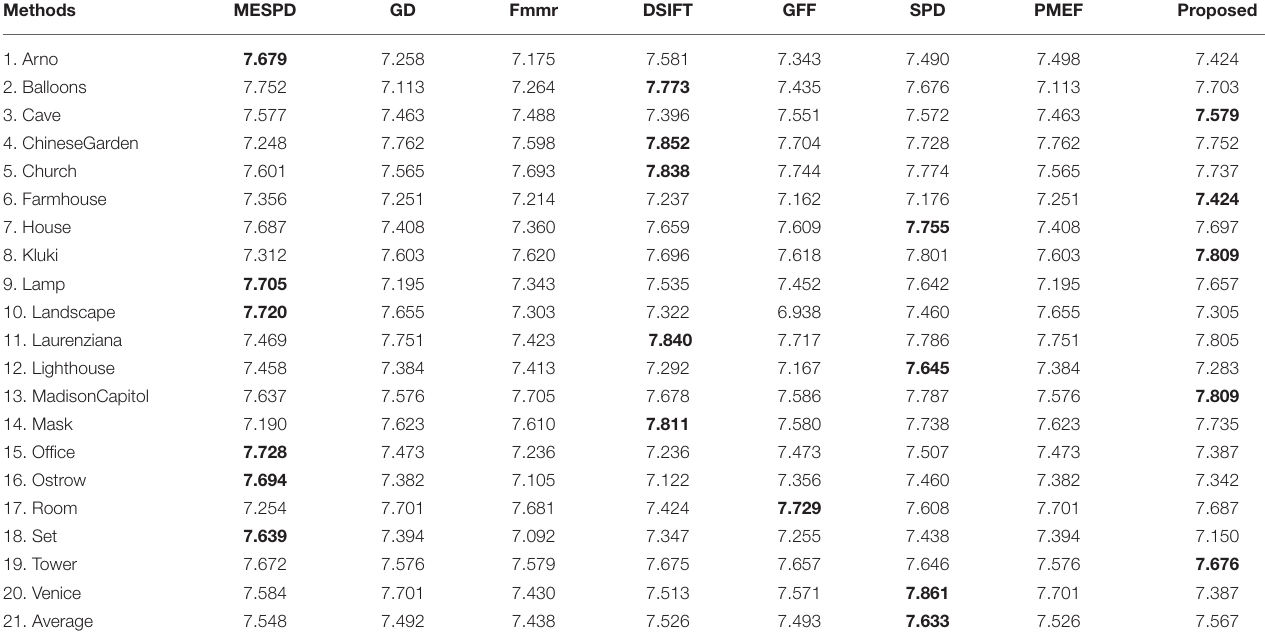
TABLE 1 | Information entropy comparison of seven fusion methods. Methods